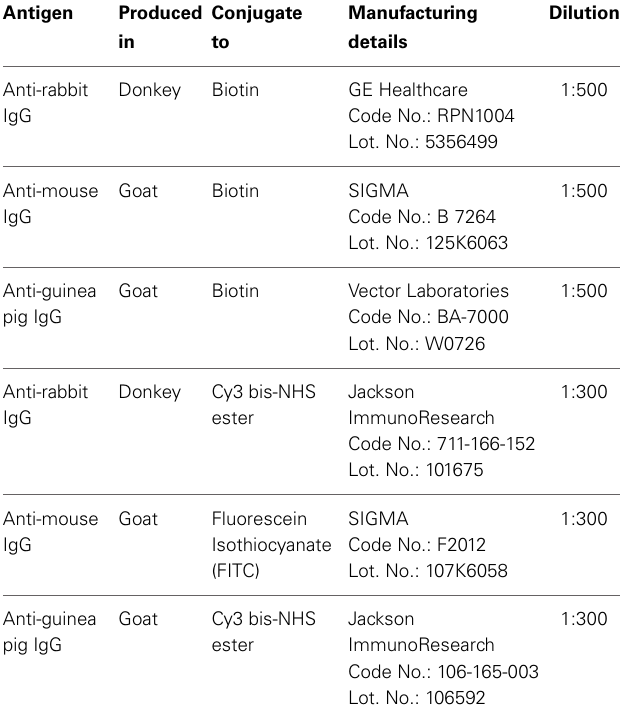
Table 2 | Secondary antibodies used.